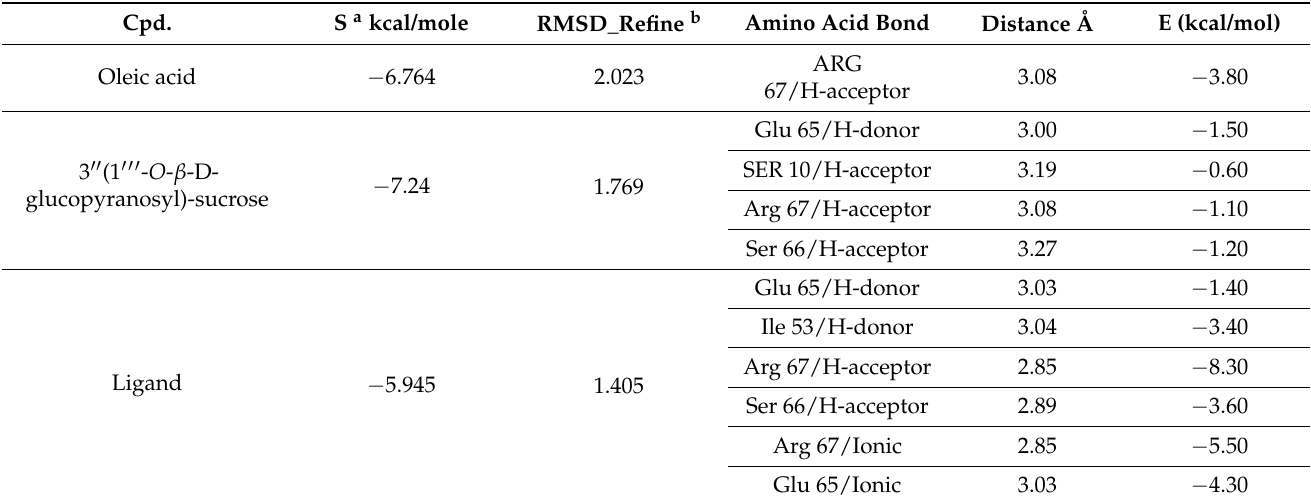
Table 5. Receptor interactions and binding energies of compounds and ligands into the active pocket site of GST catalytic